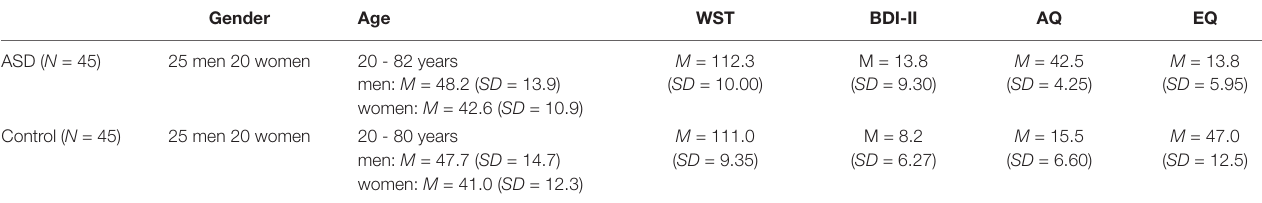
TABLE 1 | Sample characteristics.